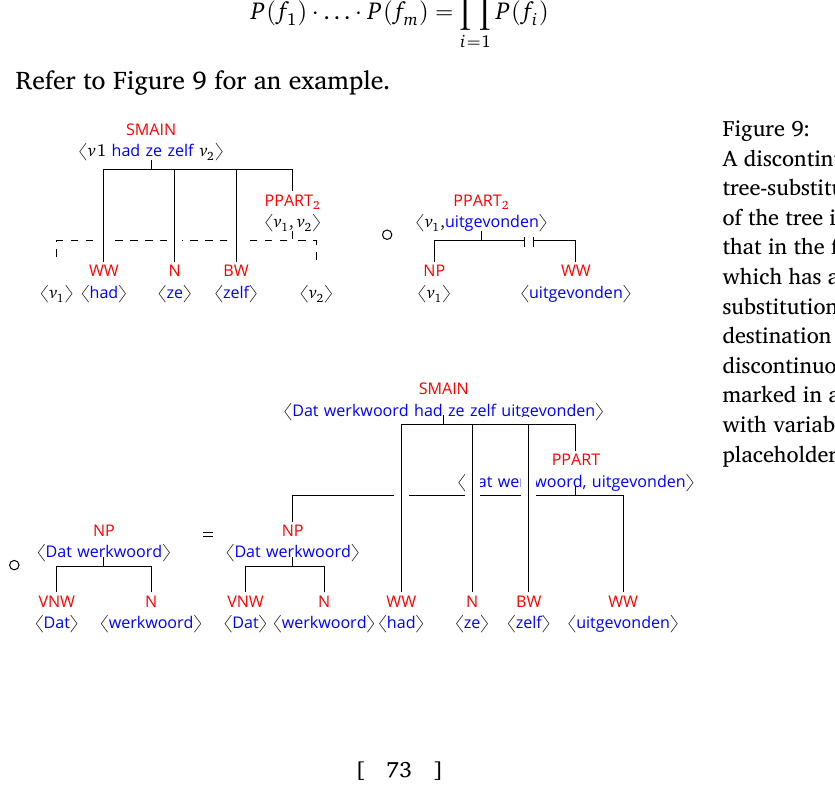
Figure 9: A discontinuous tree-substitution derivation of the tree in Figure 1. Note that in the first fragment, which has a discontinuous substitution site, the destination for the discontinuous spans is marked in advance, shown with variables ( v n ) as